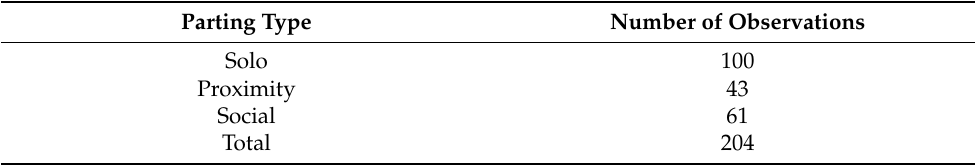
Table 3. Number of observations by parting type.